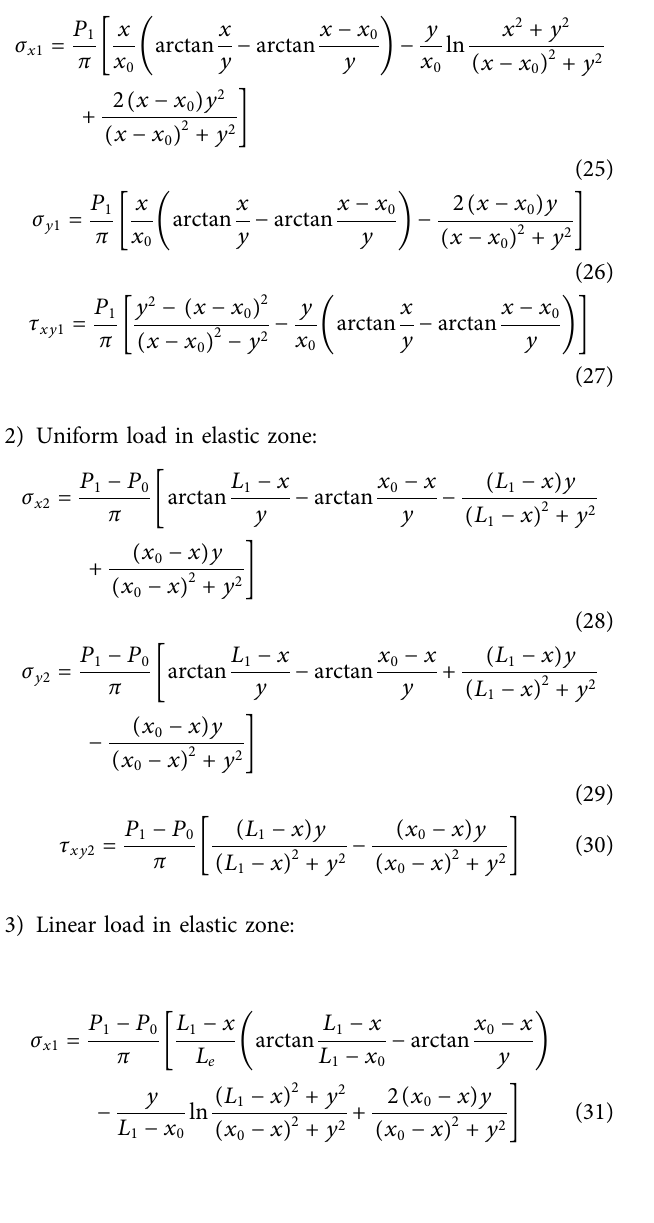
Frontiers in Earth Science |